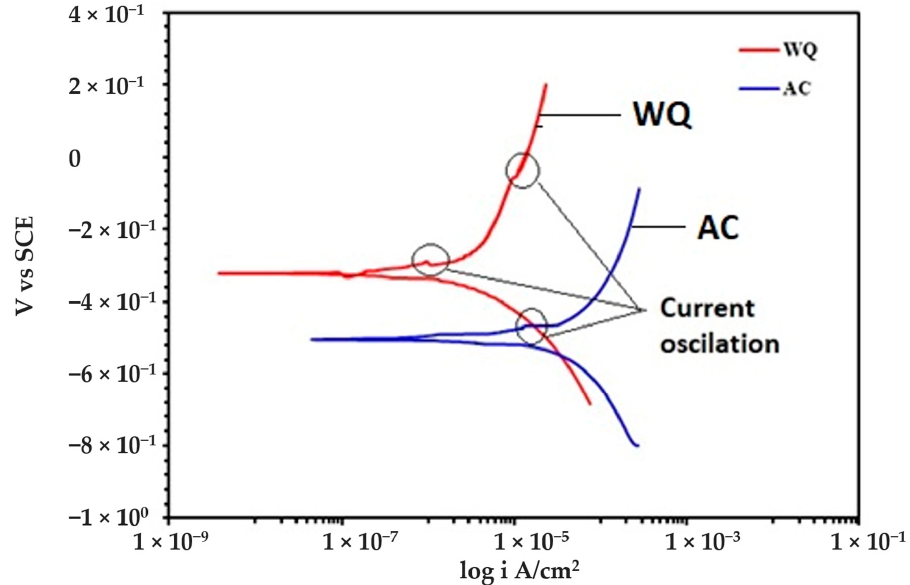
Figure 3. Potentiodynamic polarization curves of heat-treated Ti-6Al-4V alloys in Ringer’s solution. Table 3. Icorr and Ecorr values of heat-treated Ti-6Al-4V alloy in Ringer’s solution.